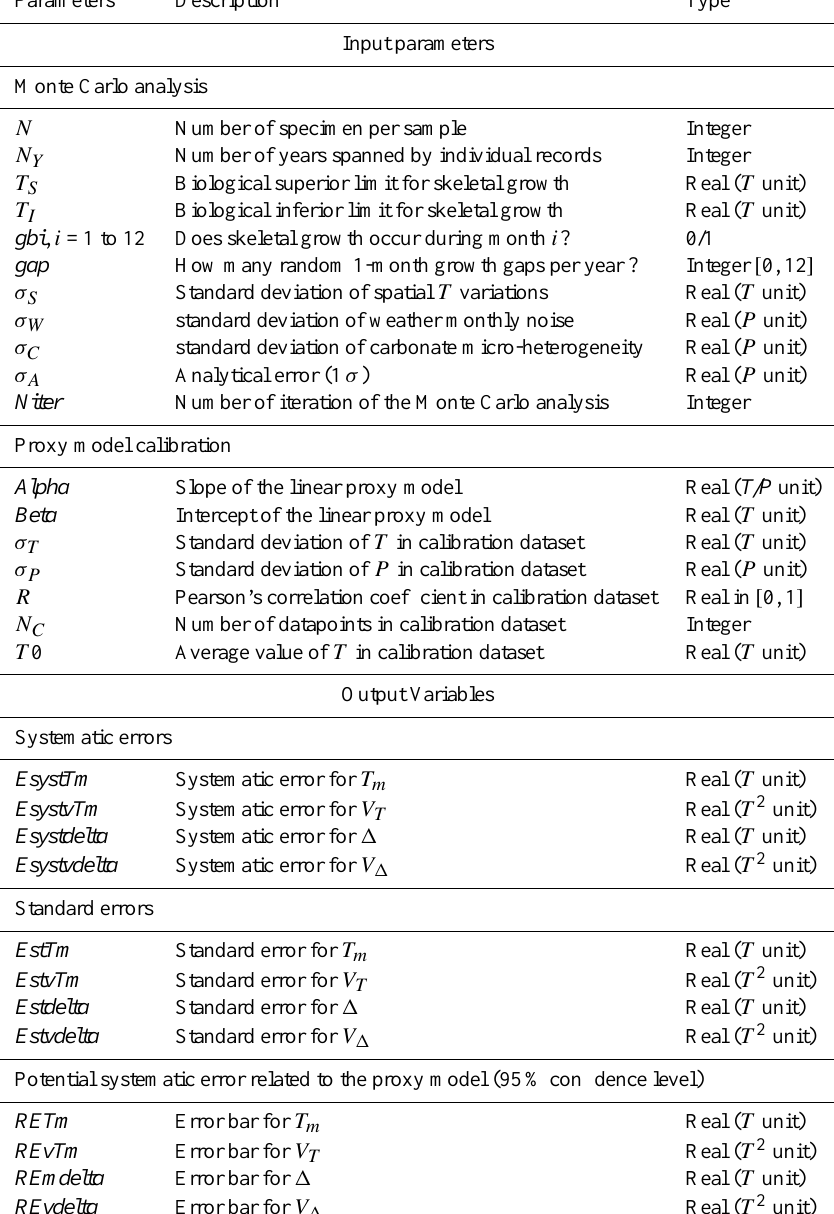
Table 1. MoCo input parameters and output